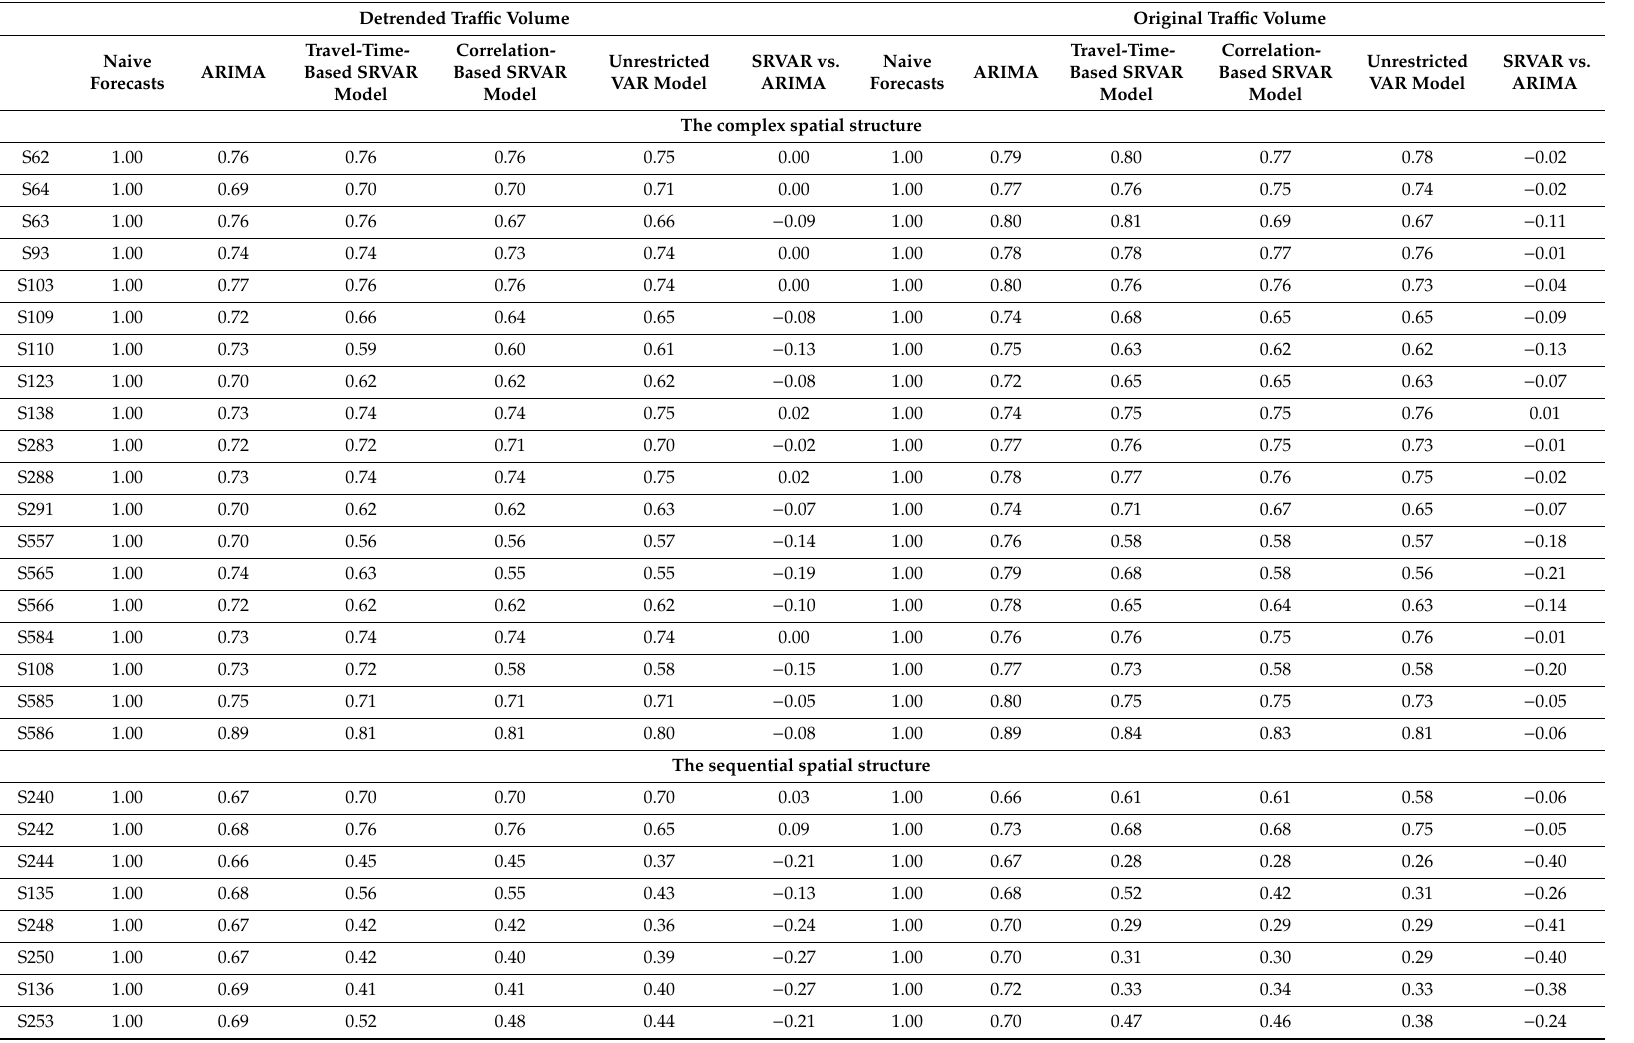
Table 4. Sensor-specific MASE